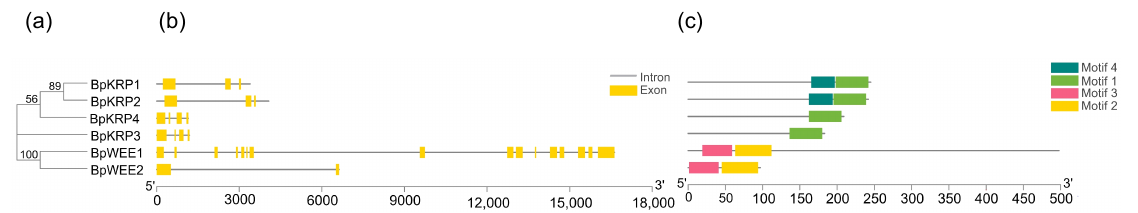
Figure 5. Phylogenetic analysis; exon/Intron genomic structure and protein motif organization of E2F , DP , DEL , and Rb in B. pendula . An unrooted phylogenetic tree was constructed using MEGA5.05 by the neighbor-joining method. Gene structure of the corresponding BpE2Fs , BpDPs , BpDELs , and BpRbs genes, TBtools software was used to visualize gene structure. The yellow boxes represent exons and grey lines represent introns. Use MEME web server to analyze the distribution of conserved motifs in BpE2Fs , BpDPs , BpDELs , and BpRbs protein. The protein motif figure of BpE2Fs , BpDPs , BpDELs , and BpRbs was constructed by TBtools software. ( a ) Phylogenetic analysis of BpE2Fs , BpDPs , BpDELs and BpRbs ; ( b ) exon/intron genomic structure of BpE2Fs , BpDPs , BpDELs , and BpRbs ; ( c ) protein motif organization of BpE2Fs , BpDPs , BpDELs , and BpRbs.